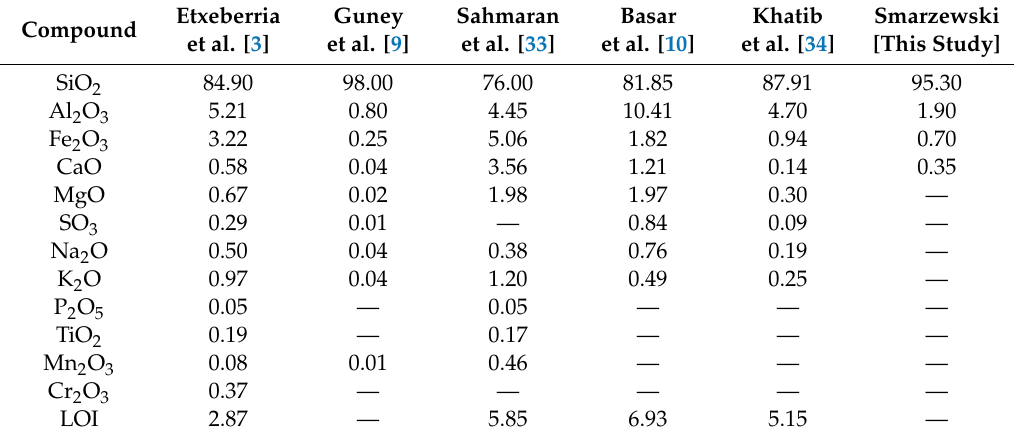
Table 5. Di ff erent chemical compositions of WFS (in